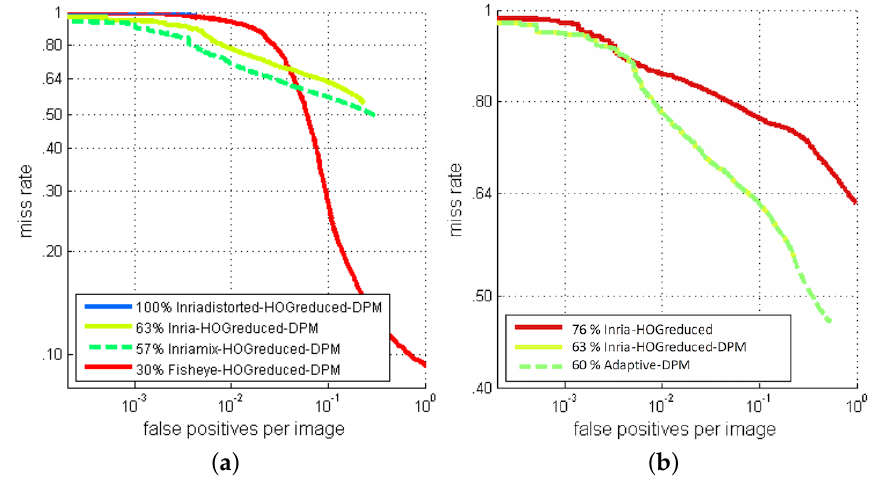
Figure 13. Detection performance of the deformable part model (DPM) approach trained with different datasets ( a ) and the adaptive-DPM approach ( b